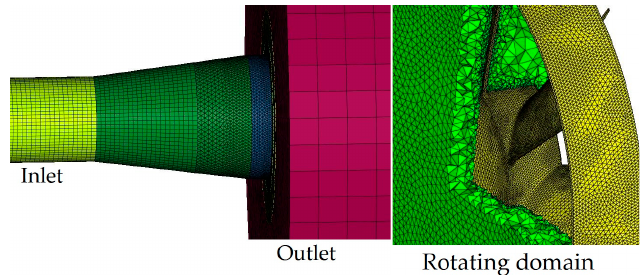
Figure 2. Mesh generation of the simulation